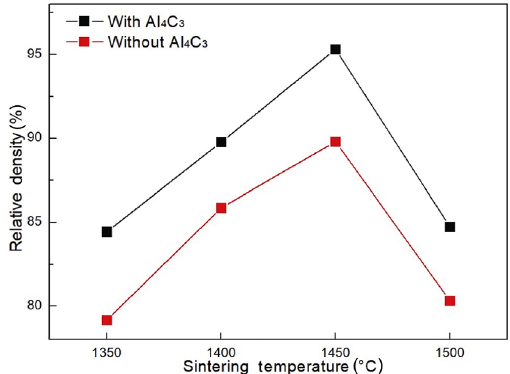
Dependence of the relative density on the sintering temperature of Ti 3 AlC 2 samples sintered with or without embedding Al 4 C 3 powders.